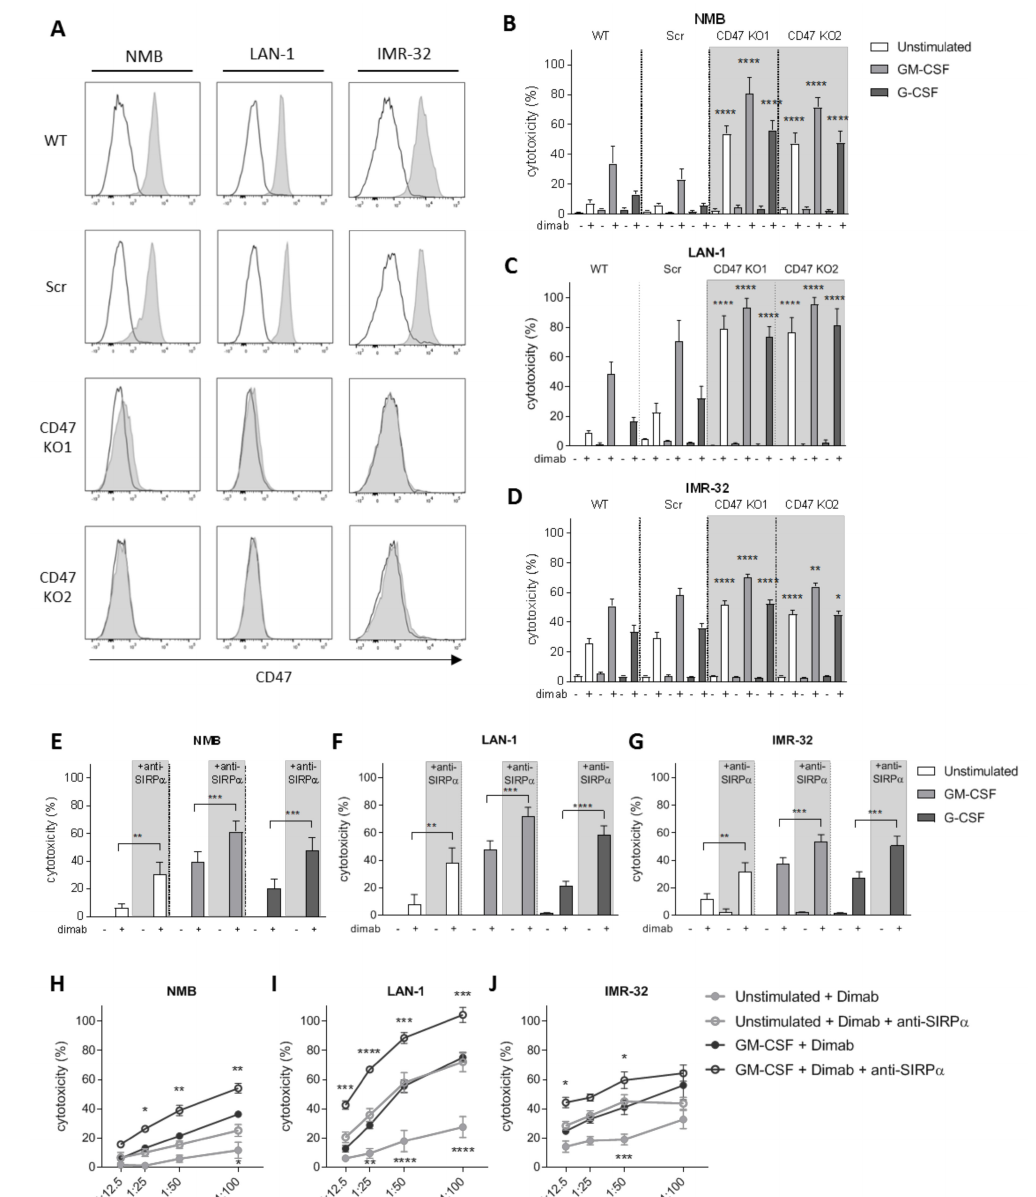
Figure 2. ( A ) Representative histograms depicting CD47 surface expression ( n = 3) as analyzed by flow cytometry on (from left to right) NMB, LAN-1, and IMR-32 control cells (top two rows) and their respective CD47 KO variants (bottom two rows). Secondary antibody controls are represented in white. ( B – D ) ADCC of control (WT and Scr, no background) and CD47 KO (CD47 KO1 and CD47 KO2, grey background) NMB ( B ), LAN-1 ( C ), and IMR-32 ( D ) cells op- sonized with (+) or without ( − ) dinutuximab (dimab) by unstimulated neutrophils (white bars) or stimulated with GM-CSF (light grey bars) or G-CSF (dark grey bars). n = 6, of 3 individual experiments. Statistics were per- formed by one-way ANOVA with Sidak correction for multiple comparisons. ( E – G ) ADCC of NMB ( E ), LAN-1 ( F ), and IMR-32 ( G ) cells opsonized with (+) or without ( − ) dinutuximab (dimab) by unstimulated neutrophils (white bars) or stimulated with GM-CSF (light grey bars) or G-CSF (dark grey bars) in the absence (no background) or presence (grey background) of SIRP α blocking agent. n = 6–14, of 7 independent experiments. Statistical analysis was assessed with by a paired t -test. ( H – J ) ADCC of dinutuximab-opsonized NMB ( H ), LAN-1 ( I ), and IMR-32 ( J ) cells by unstimulated neutrophils (light grey circles) or stimulated with GM-CSF (dark grey circles) in the absence (filled circles) or presence (empty circles) of SIRP α blocking agent at different T:E ratios ranging from 1:12.5 to 1:100. n = 5, of 4 individual experiments. Statistical differences were tested with two-way ANOVA with Tukey’s post hoc test; * p < 0.05; ** p < 0.01; *** p < 0.001; **** p < 0.0001. ADCC, antibody-dependent cellular cytotoxicity. WT, wildtype. Scr,